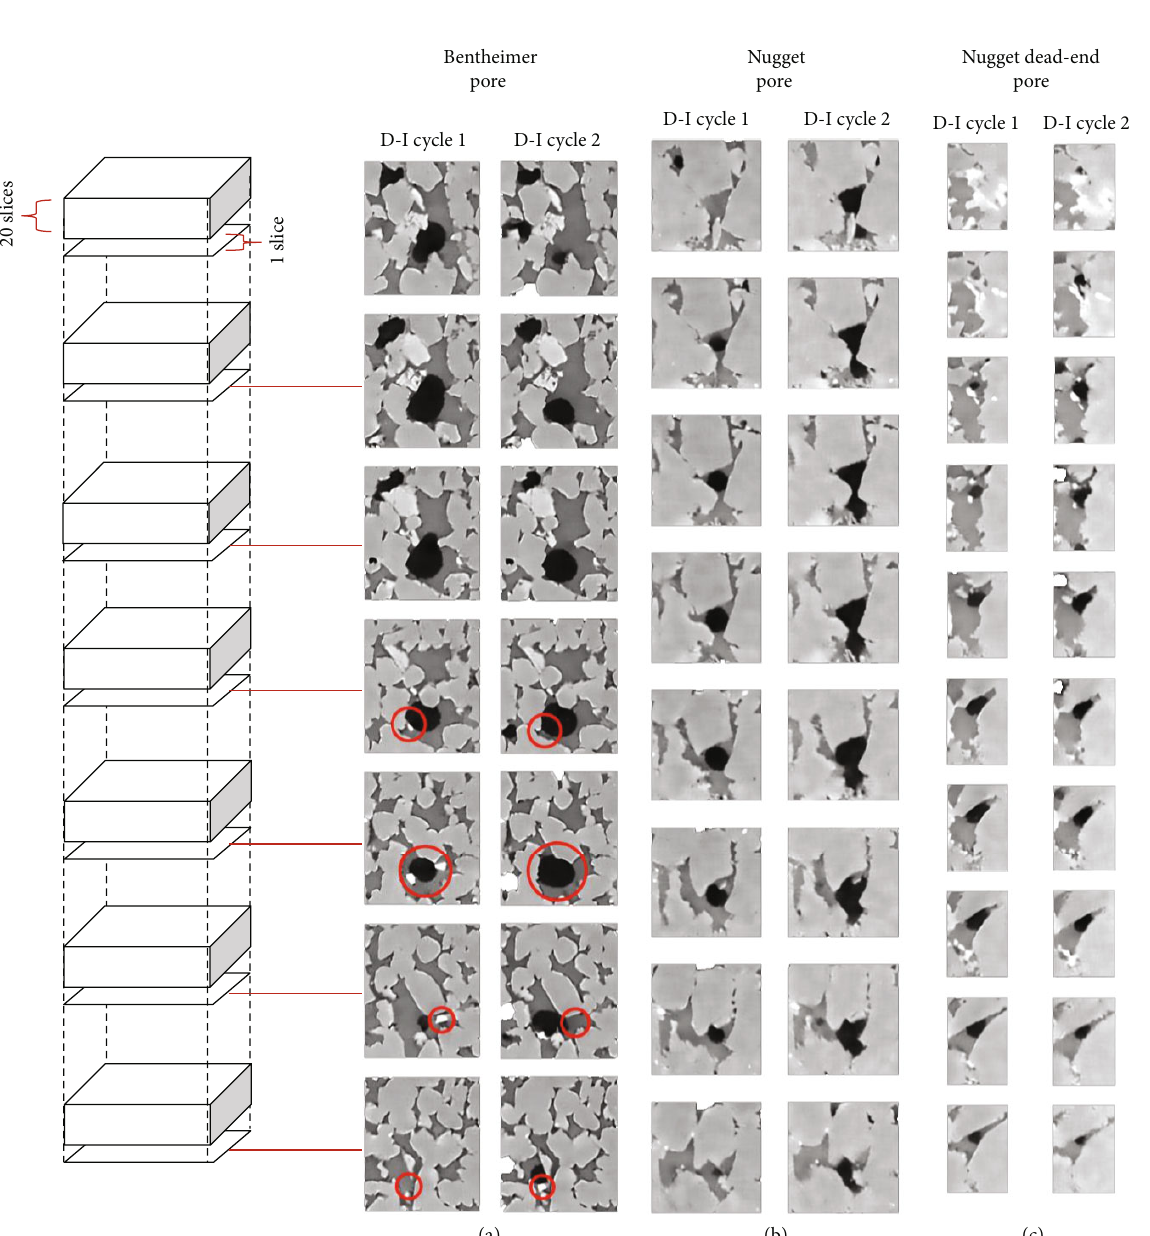
Figure 7: Bentheimer pore, Nugget pore, and Nugget dead-end pore cross-section views. Red circles highlight high density particles that migrated in the Bentheimer pore between D-I cycles.